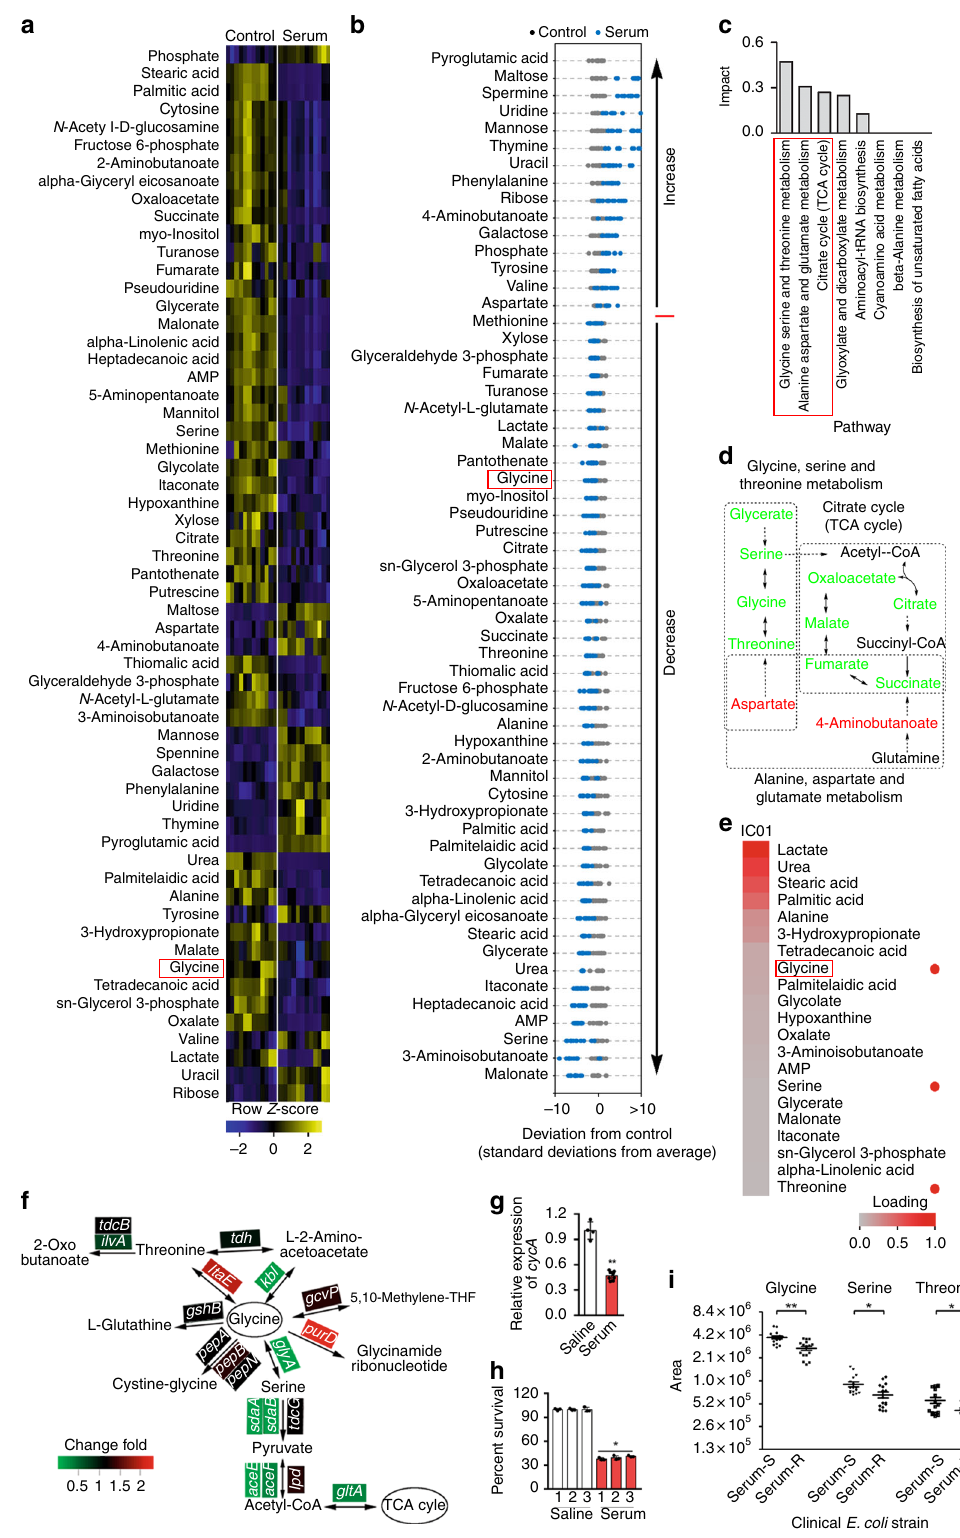
Figs. 6 and 7a – c). As compared to the control group, metabolites belonging to glycine, serine and threonine metabolism and to TCA cycle were lower in serum-exposed bacterial cells but increased when exposed to serum plus glycine except for threo- nine, which was decreased (Fig. 3a; Supplementary Figs. 7d and 7e). However, when serum plus glycine group was compared